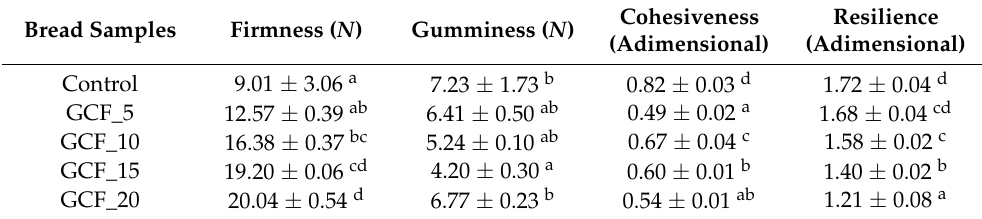
Table 6. Texture data of bread samples with different levels of GCF addition in wheat flour. Bread Samples Firmness ( N ) Gumminess ( N )